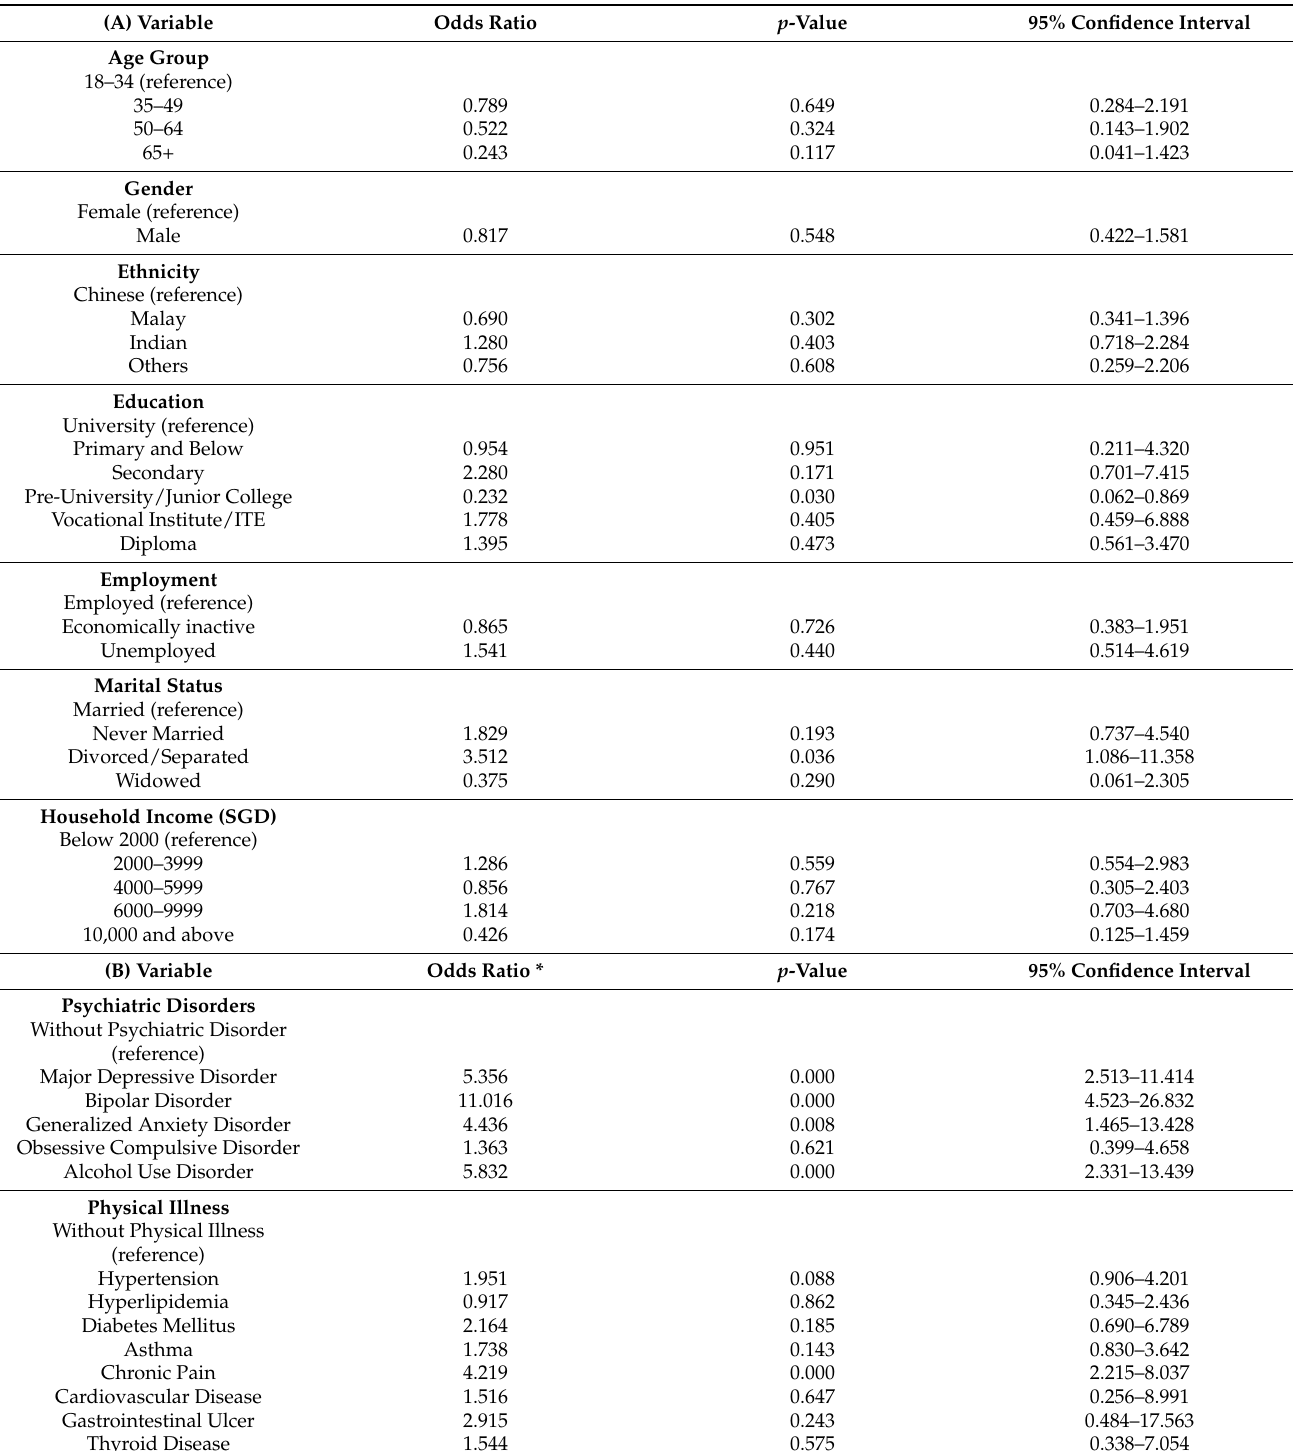
Table 3. ( A ). Socio-demographic factors of suicidal planning. ( B ). Associations among suicidal planning, physical, and psychiatric disorders.